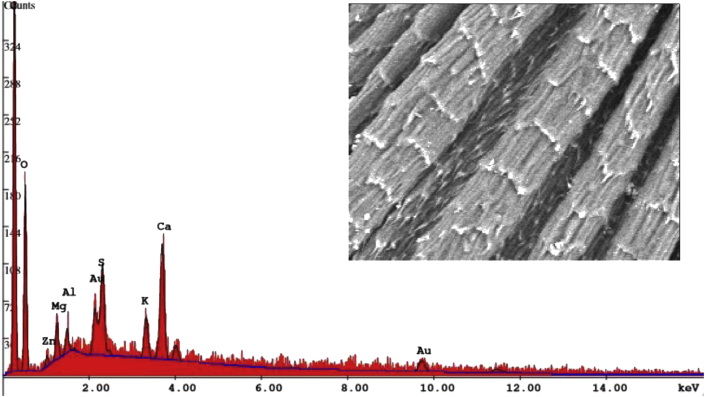
SEM image right-hand side panel and EDX spectra left-hand side panels of lettuce seed treated with 25 ppm ZnO NPs. The EDX spectra sampled from SEM areas. EDX spectrum shows Zn peak of atomic zinc origin ZnL. Prominent peaks were detected;. C, O, Mg, Al, S, K, Ca, denote corresponding chemical elements. The ending letters K and L denote the characteristic binding energies of the electron shells.